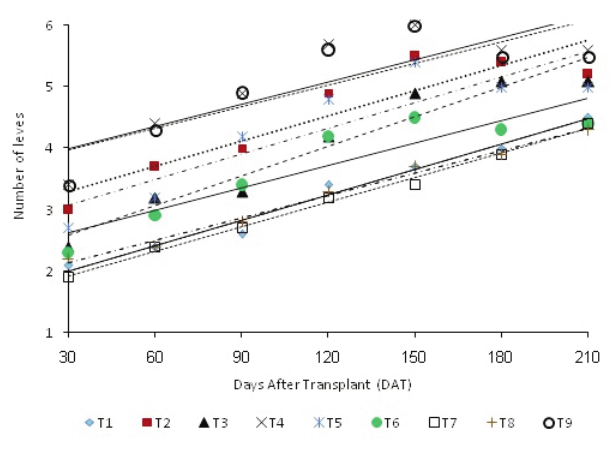
Fig. 3 ­ Effect of different combinations of substrates on the number of leaves per plant in açaí seedlings ( Euterpe ole‐ racea Mart.) under nursery conditions. T1= sand, T2= commercial substrate (OrganoAmazon © ), T3= 25% T1 + 75% manure, T4= 50% T1 + 50% manure, T5= 75% T1 + 25% manure, T6= 25% T1 + 75% burnt rice husks, T7= 50% T1 + 50% burnt rice husks, T8= 75% T1 + 25% burnt rice husks, T9= 25% soil + 25% sand + 25% manure +